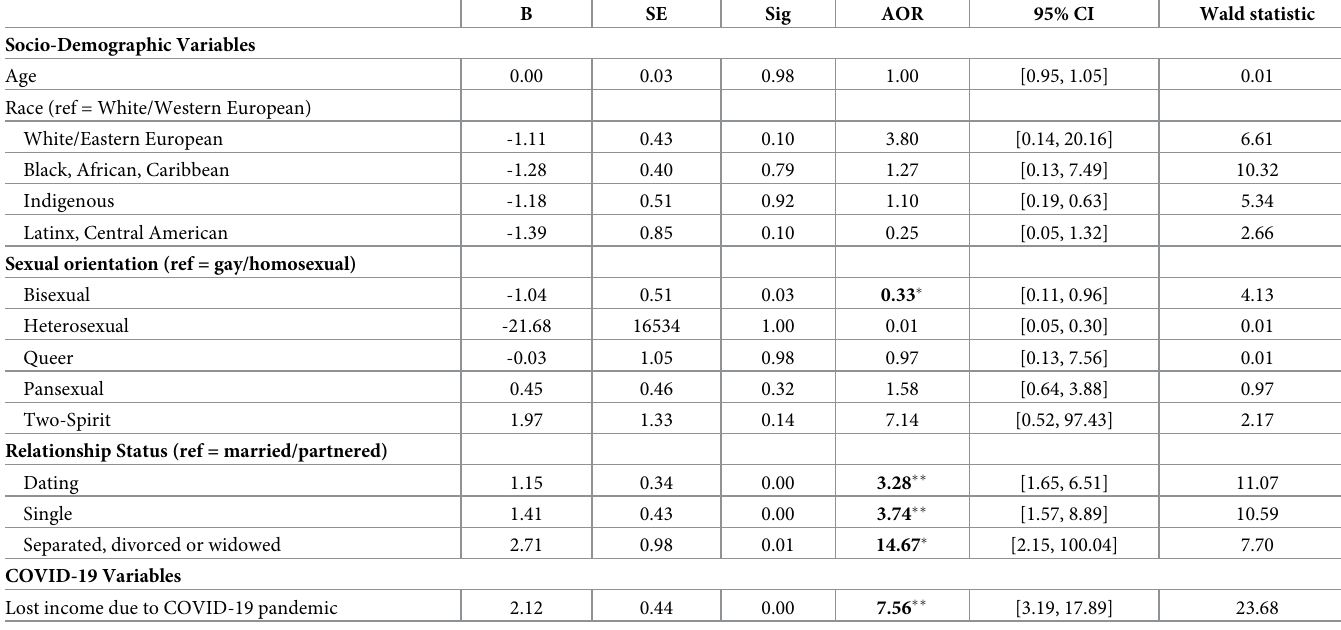
Table 2. Multiple logistic regression of socio-demographics and lost income on worsening of mental health due to the COVID-19 pandemic among two-spirit, gay, bisexual, and queer men in Manitoba ( N = 366). B SE